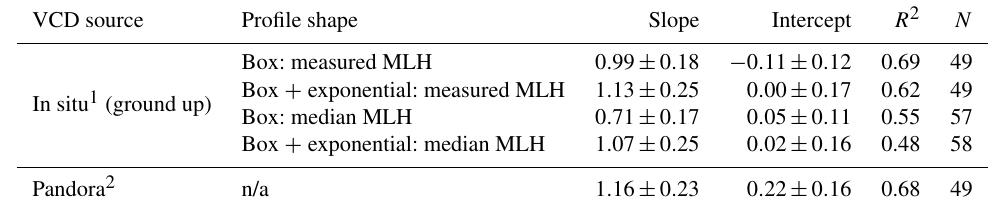
Table 3. Linear correlation between HCHO total columns from Pandora direct-sun measurements and columns calculated from in situ surface concentration measurements based on different profile shape assumptions ( Y ) vs. HCHO-integrated columns from DC-8 ( X ).